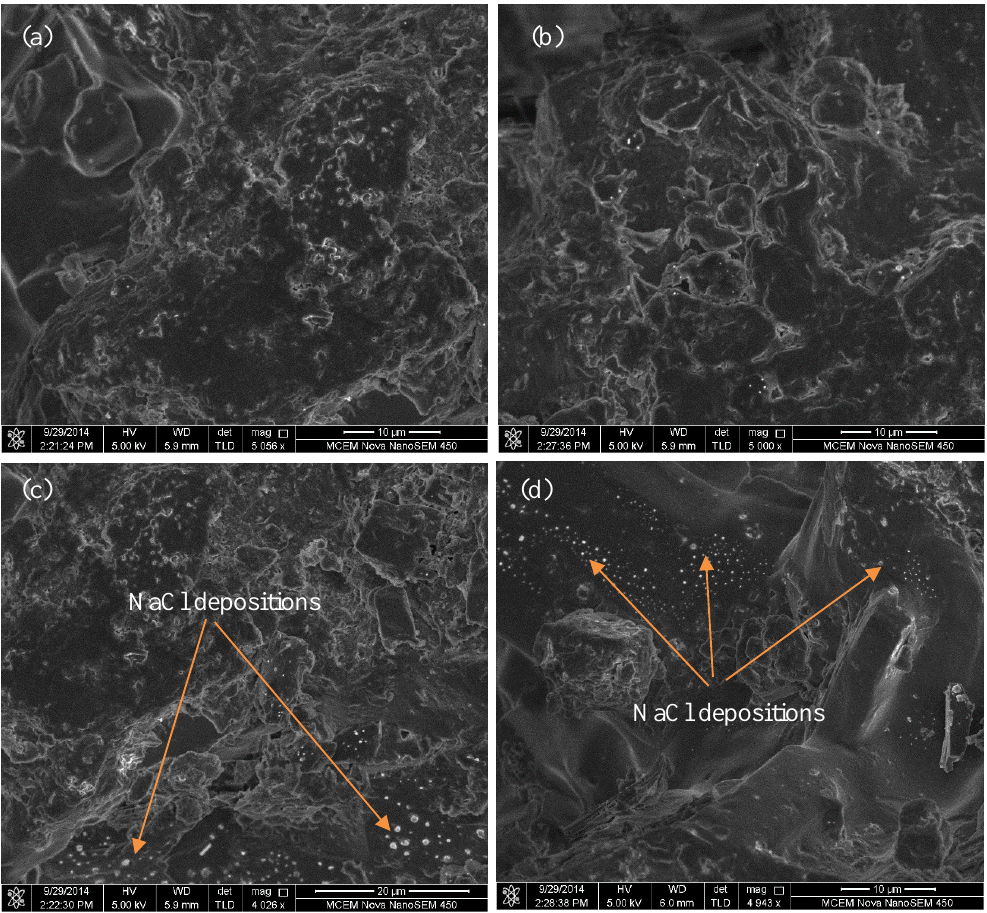
Figure 8. SEM test results of ( a ) water-saturated ( b ) 10% NaCl-saturated ( c ) 20% NaCl brine-saturated and ( d ) 30% NaCl-saturated specimens. Note that the higher order concentrations of NaCl cause NaCl precipitation in siltstone pores, resulting in a slight strength increment.